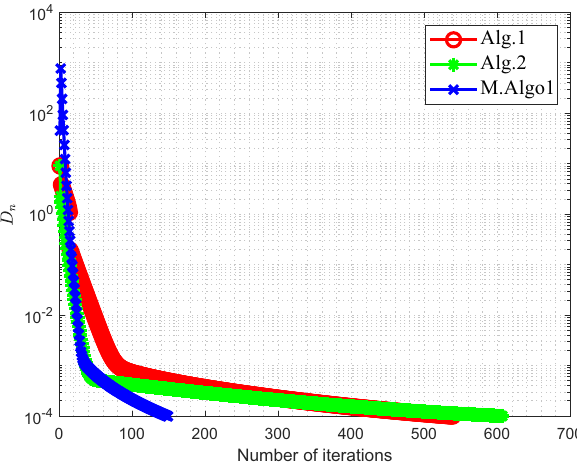
Figure 4: Numerical comparison of Algorithm 1 with Algorithm 1 in [ 30 ] and Algorithm 2 in [ 30 ] taking = N